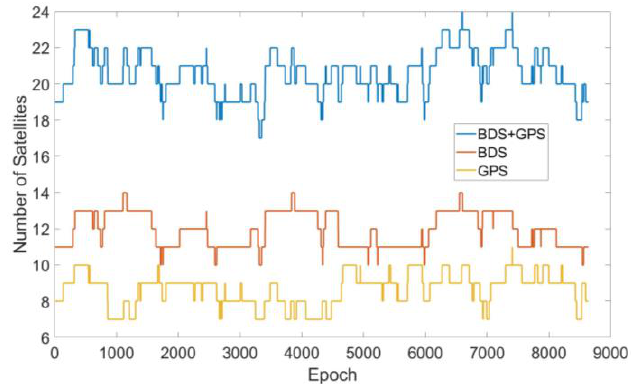
Figure 6. The number of satellites during simulation.